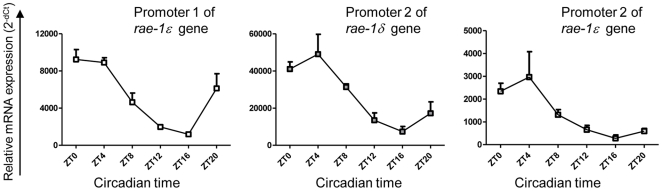
All transcripts are characterized by a circadian rhythm.RT-qPCR were performed on C57BL/6 livers dissected at different Zeitgeber time (ZT) with three sets of primers: exon 1-exon 3a primers which detected the Rae-1ε transcripts under the control of the promoter 1, exon 3b with either exon 6δ or exon 6ε primers allowing the quantification of transcripts under the control of the promoter 2. Results are expressed as mean of 3 livers +/− SEM at each ZT relatively to GAPDH as endogenous control.